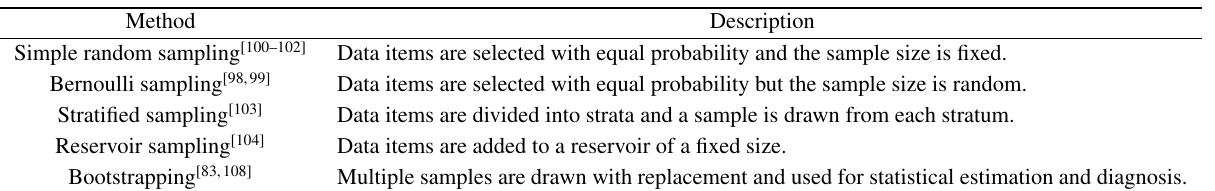
Table 2 A summary of common sampling